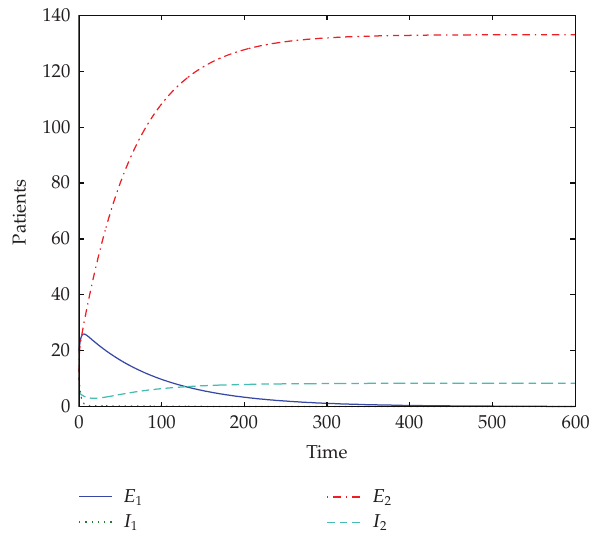
Figure 12: Trajectories of system (cid:2) 2.2 (cid:3) when β 1 (cid:2) N (cid:3) (cid:8) β 1 C (cid:2) N (cid:3) , β 2 (cid:2) N (cid:3) (cid:8) β 2 C (cid:2) N (cid:3) , C (cid:2) N (cid:3) (cid:8) N/ (cid:2) 1 (cid:9) N (cid:9) √ 1 (cid:9) 2 N (cid:3) , β 1 (cid:8) 0 . 001, β 2 (cid:8) 1, d 1 (cid:8) 0 . 02, d 2 (cid:8) 0 . 07, so that R 1 < 1, R 2 > 1. It shows that the boundary equilibrium P 1 is